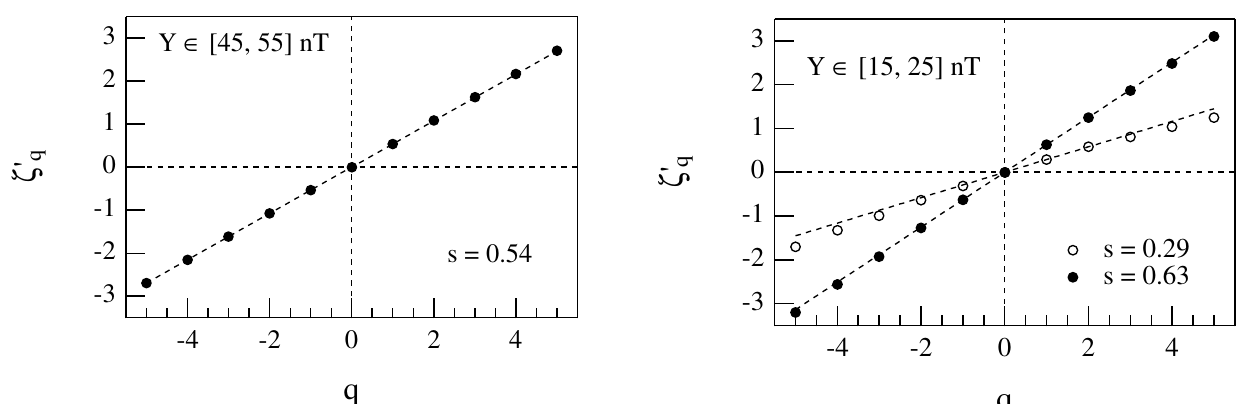
Fig. 5. Plot of ζ 0 ( q ) vs q to confirm the mono-fractal scaling with scaling exponent s = 0 . 54 in the range Y ∈ [45 , 55] nT. The dashed line is the line ζ 0 ( q ) = 0 . 54 q .